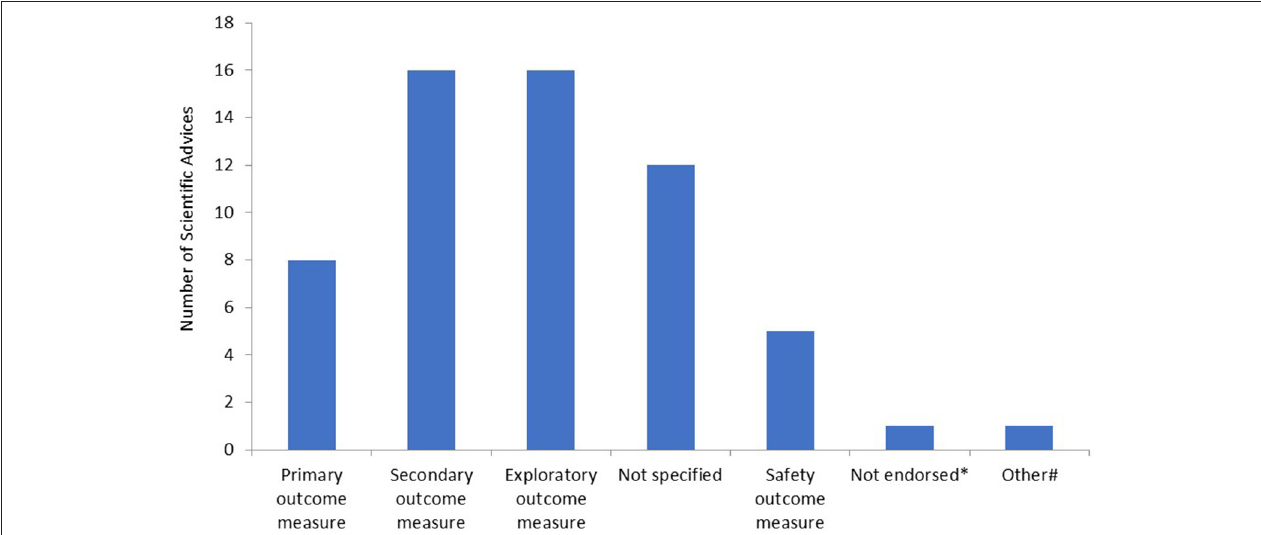
FIGURE 2 | Type of endpoints as measured by remote monitoring technologies. *In this scientific advice (SA), the remote monitoring technology (RMT) was not endorsed by the Committee for Medicinal Products for Human Use (CHMP) and another method for outcome measurement was proposed by the CHMP; # in this SA, the RMT was used in an explorative natural history